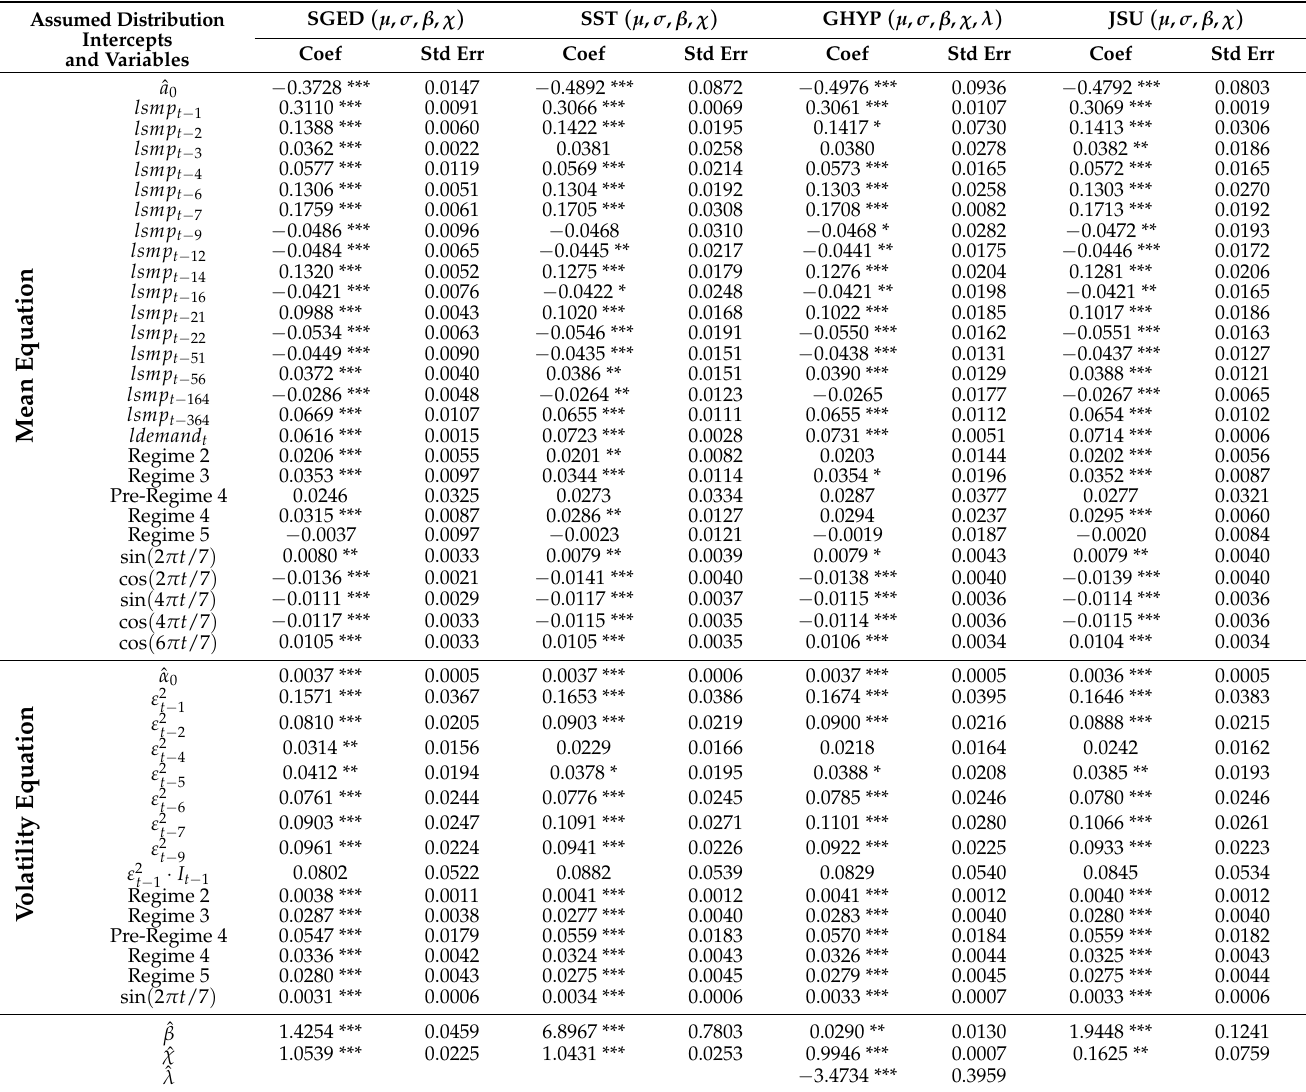
Table 2. Estimation results based on the maximum likelihood method when assuming skew gen- eralized error distribution, skew Student’s t distribution, generalized hyperbolic distribution, and Johnson’s S U